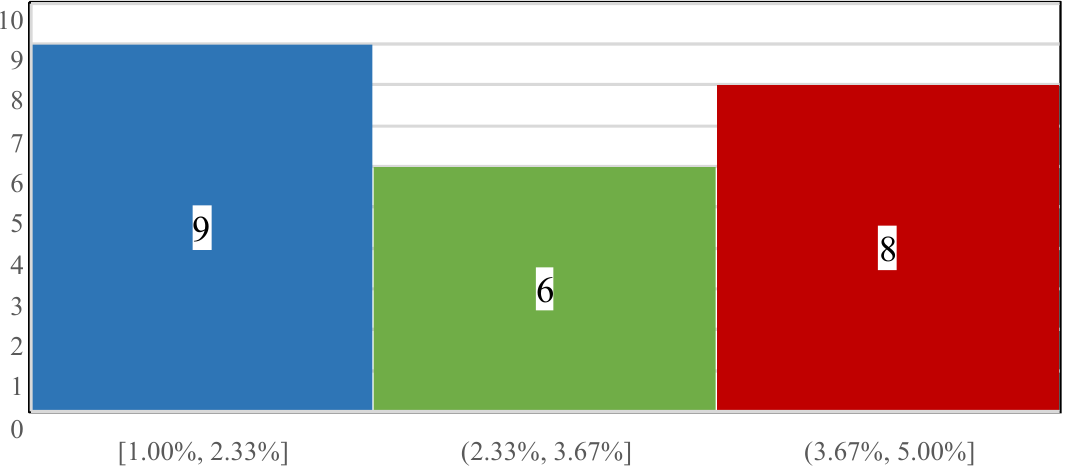
Figure 4. The number of patients stratified via affected burn surface ranges.